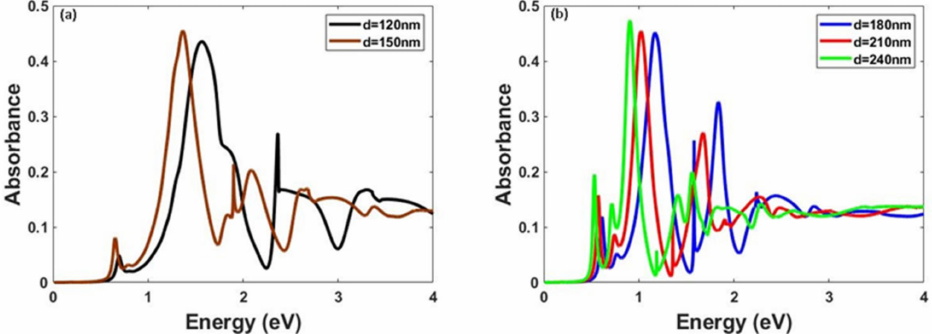
Figure 2. Size-dependent LSPRs for a = 3 d and ( a ) d = 120 nm & 150 nm; ( b ) d = 180 nm–240